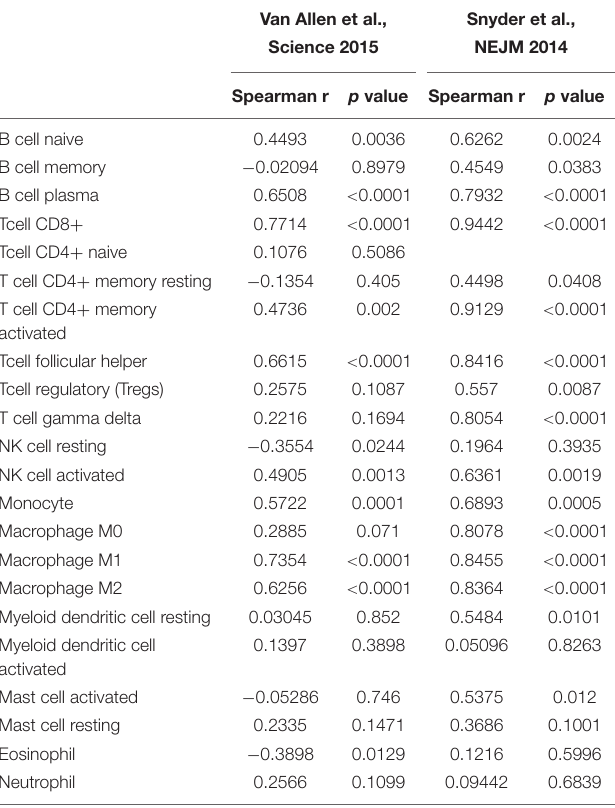
TABLE 3 | Correlation between NLRC5 expression and infiltrating level of immune cell in melanoma receiving immunotherapy. Van Allen et al., Snyder et